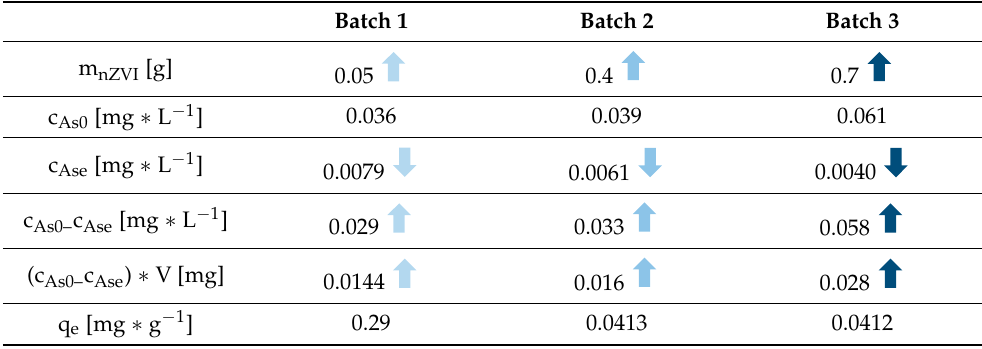
Table 7. The amount of adsorbed As at equilibrium in mg ∗ g − 1 for Test